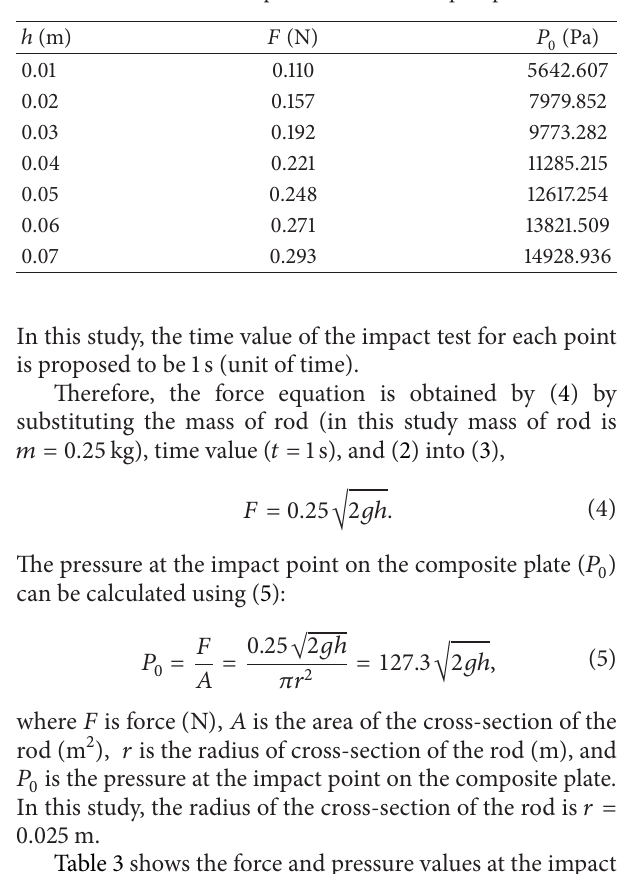
Table 3: Force and pressure values at impact point.